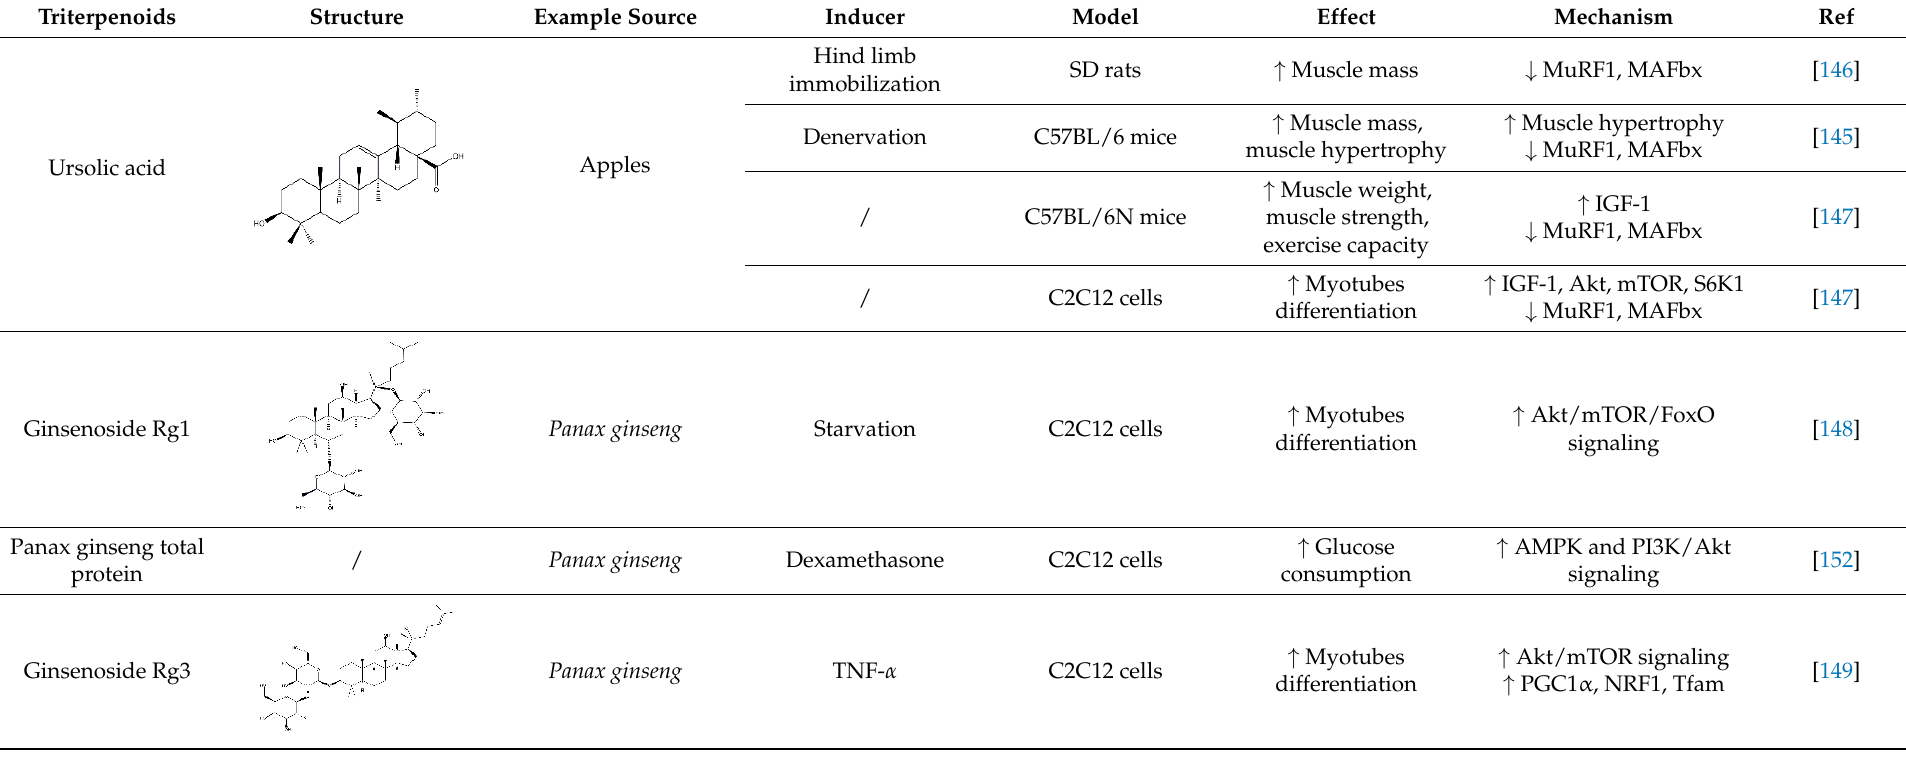
Table 9. Triterpenoids in the prevention of the muscle atrophy in vitro/vivo.